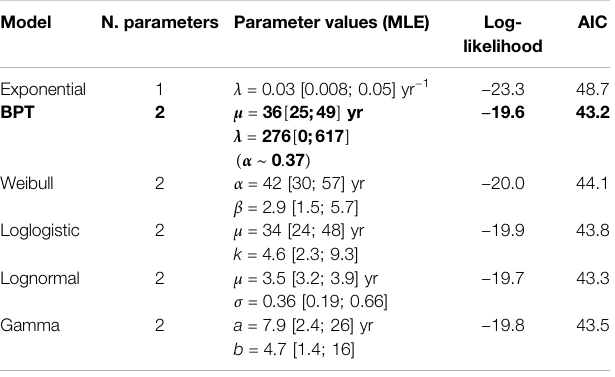
The parameters of the fi tted models consideringother cluster partitionsare presented in the Supplementary Material . In bold we highlight the model with lower AIC (and therefore, the preferred model). In square brackets we provide the 95% con fi dence intervals.